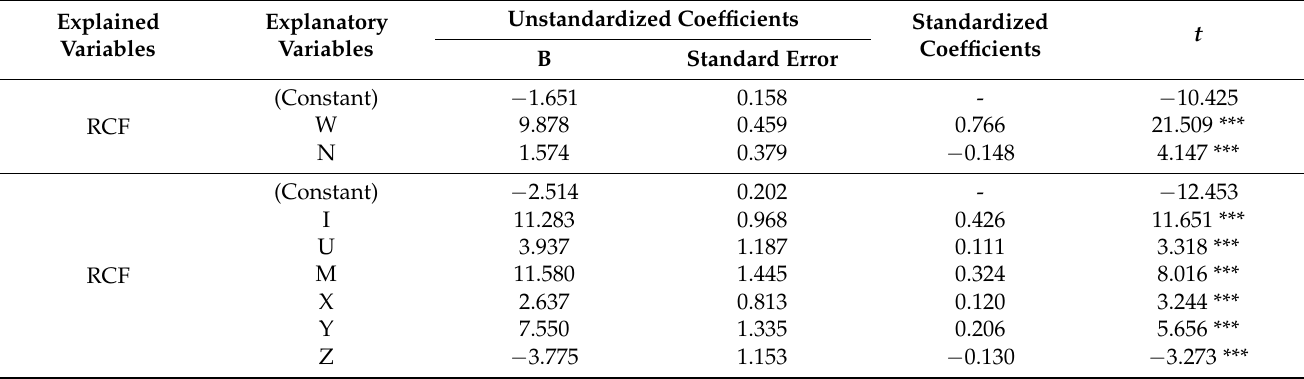
Table 3. Regression analysis results of influencing factors for the changes of comprehensive functions in rural areas of Jianghan